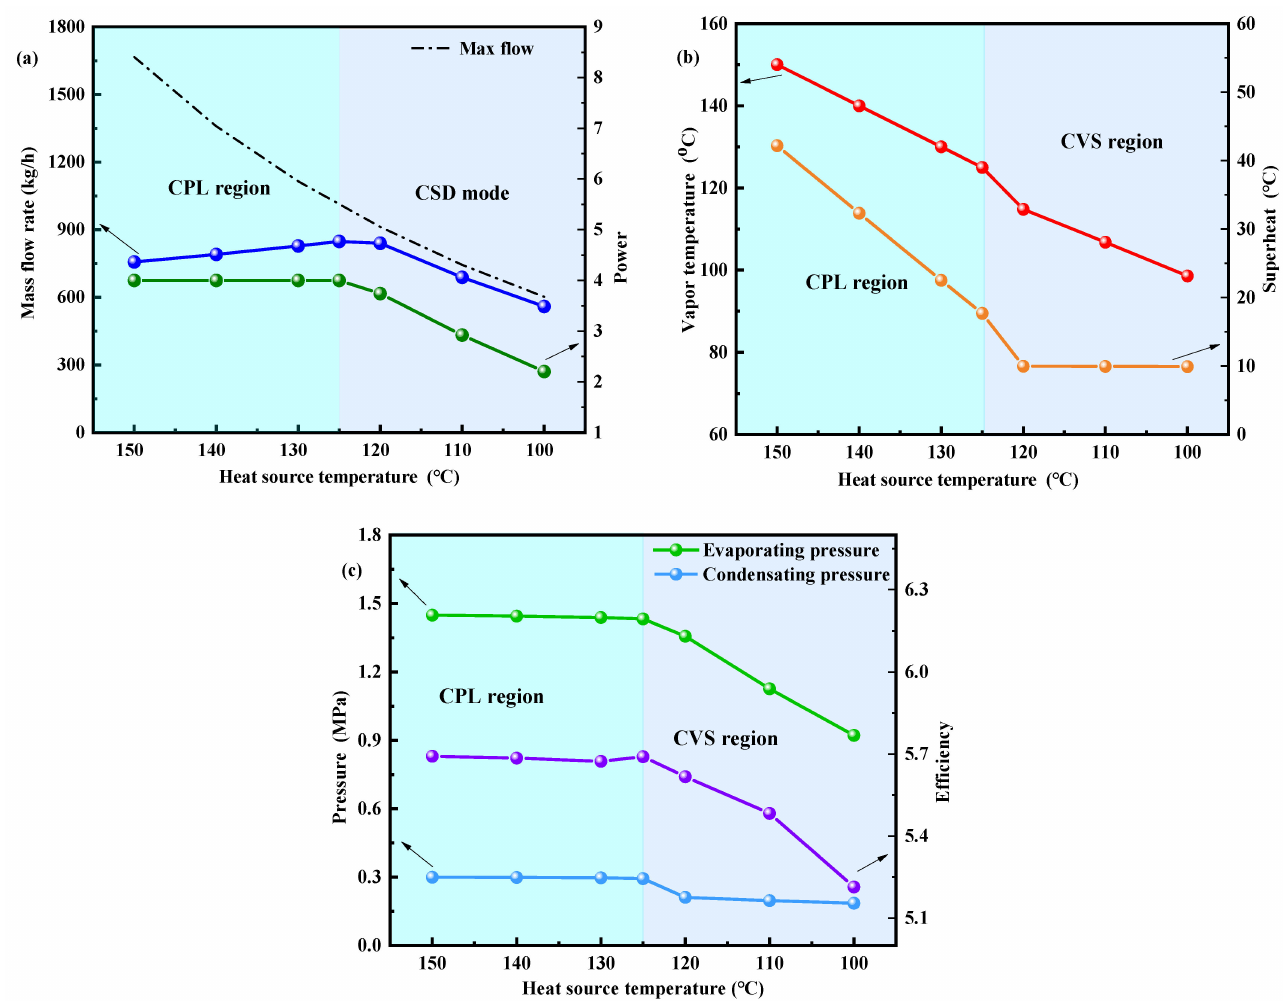
Figure 14. Variation of key parameters of the ORC system with heat source temperature under CVS and CPL modes. ( a ) mass flow rate and power, ( b ) vapor temperature and superheat, ( c ) vapor pressure and thermal